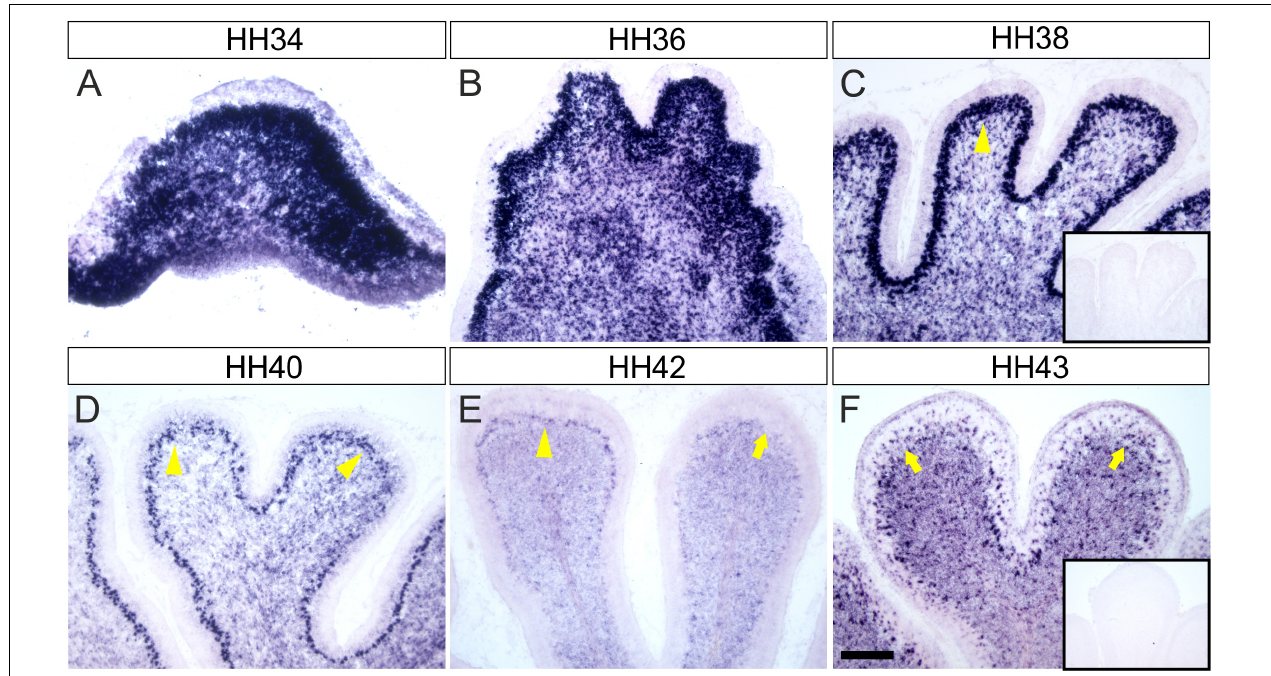
FIGURE 1 | Endoglycan is expressed in different cell types during cerebellar development. (A) Endoglycan mRNA was detected already at early stages of cerebellum development, when cells born in the ventricular zone start migrating radially toward the periphery of the cerebellar anlage at HH34/E8 (Hamburger and Hamilton stage 34; Hamburger and Hamilton, 1951). Endoglycan is found scattered throughout the cerebellar tissue at HH36/E10 (B) and HH38/E12 (C) . At both stages, Endoglycan is expressed also in Purkinje cells. The Purkinje cell layer is labeled with yellow arrowheads. By HH40/E14 (D) , Purkinje cells have completed their migration and are about to align to a single cell layer. The single cell layer is perfectly formed at HH42/E16 (E) . At this stage, the intensity of the Endoglycan mRNA signal is strongly reduced in some lobes (arrow). By HH43/E17 (F) , Purkinje cells appear to express little, if any Endoglycan mRNA. However, as at earlier stages, Endoglycan is still found in the inner granule cell layer and now also in interneurons of the molecular layer. Inserts show adjacent sections hybridized with the sense probe as negative control. Bar, 200 µ